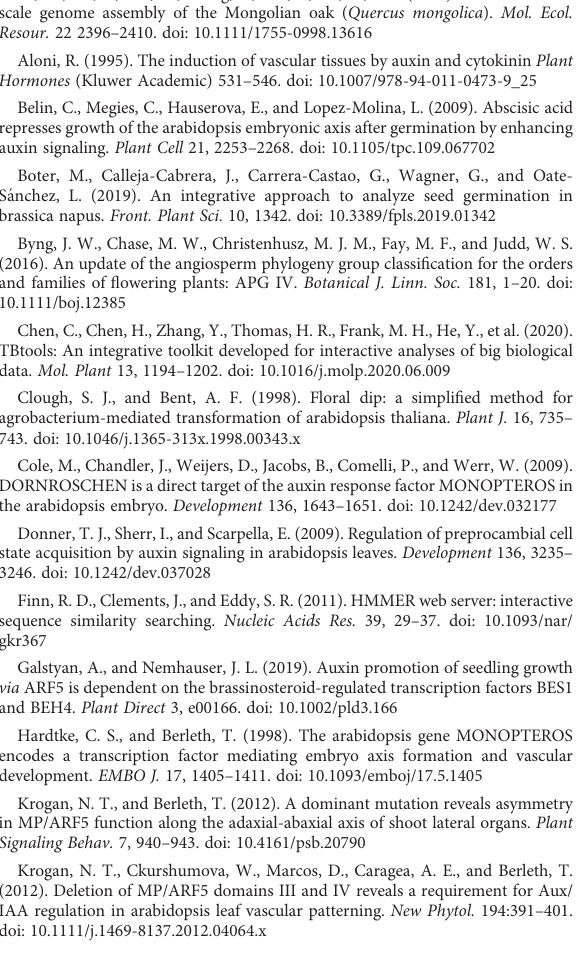
SUPPLEMENTARY TABLE 1 PCR primer names and